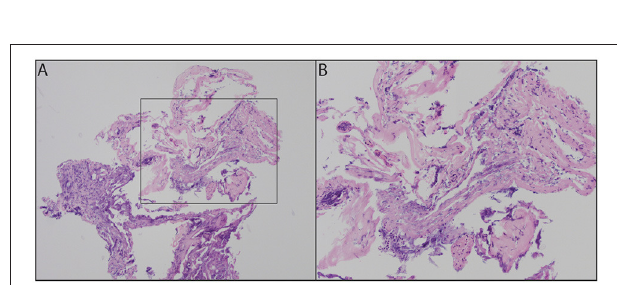
FIGURE 3 | Fibrous tissue with acute inflammatory infiltrate and cauterization artifacts at 100x (A) and 200x (B)